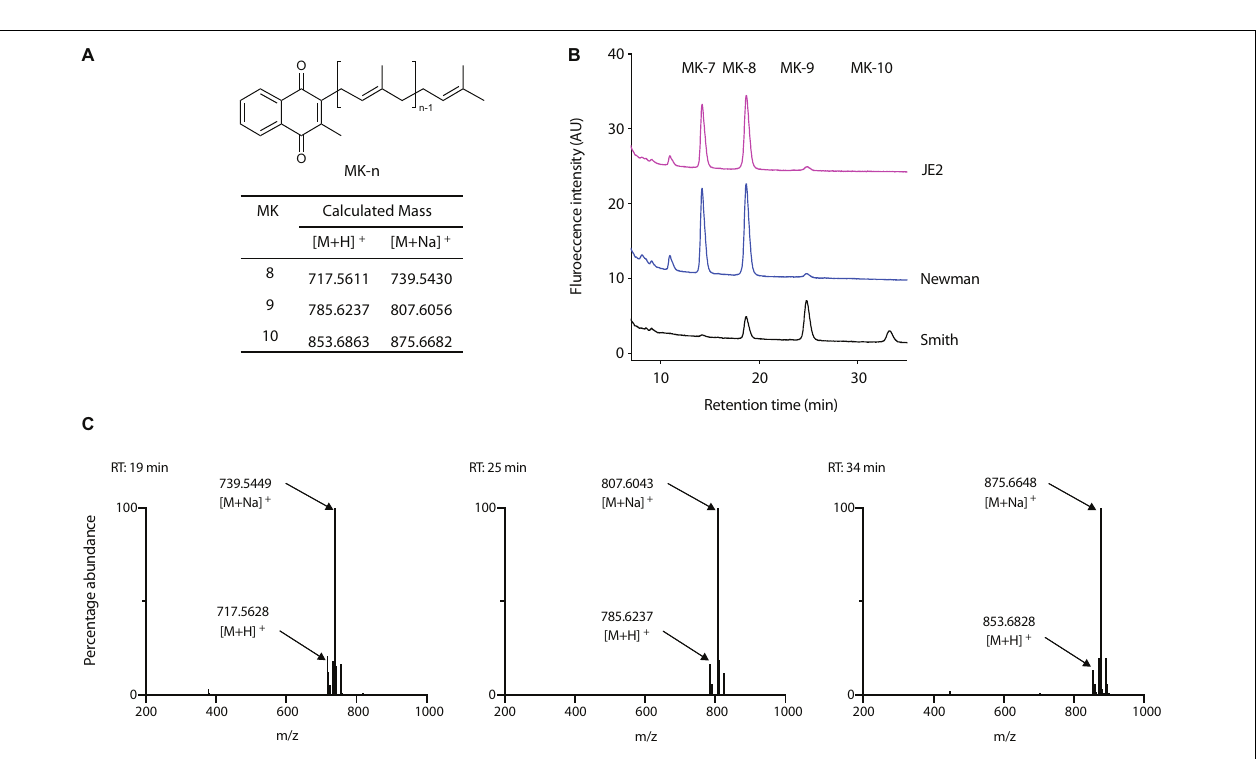
FIGURE 2 | Analysis of MKs from S. aureus . (A) Chemical structure of MK-n and calculated exact mass of MK-8, 9, and 10 in positive ion analysis. (B) Analysis of MK extract from S. aureus Smith, Newman, and JE2. (C) High-resolution mass spectrometric analysis of peaks that appeared in Smith at 19, 25, and 34 min.